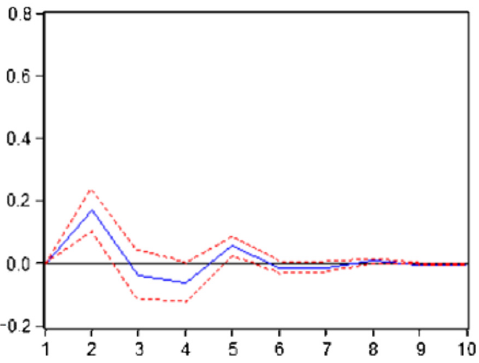
Figure 8. Impulse response of Shanghai copper to London copper return rate.